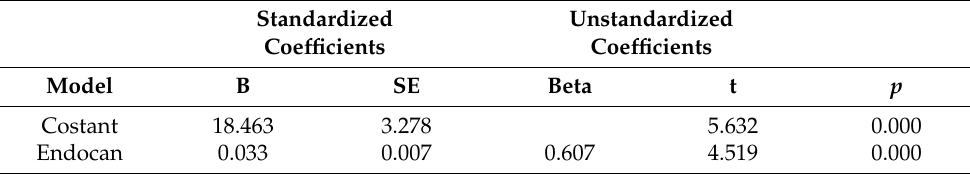
Table 6. Multivariable regression